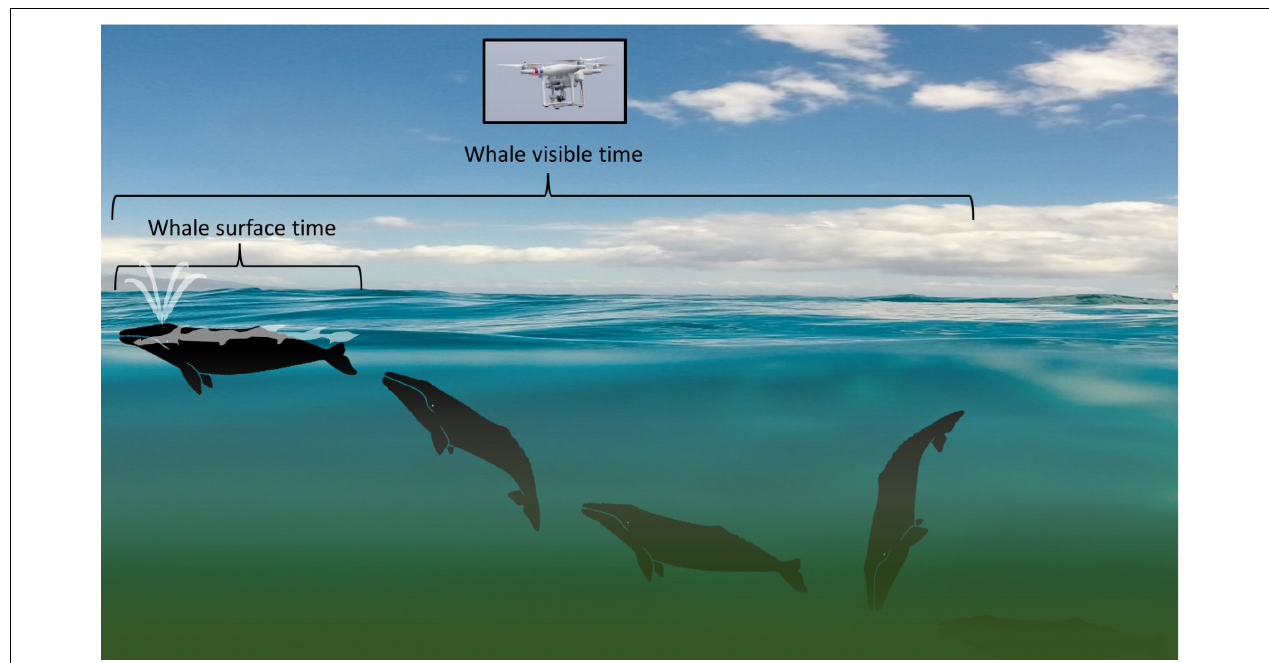
FIGURE 1 | Diagram illustrating “whale surface time” relative to “whale visible time” data as collected from an unmanned aerial systems (UAS) aircraft flying over a gray whale as it moves sequentially (from right to left) from “headstand” foraging to surfacing. Decreased visibility through the water column due to turbidity is illustrated by shading. Background image provided by Matt Flores on Unsplash with permission for use; gray whale images by iStock.com/KBelka with permission for use; UAS photo of a DJI Phantom 3 Pro by L.